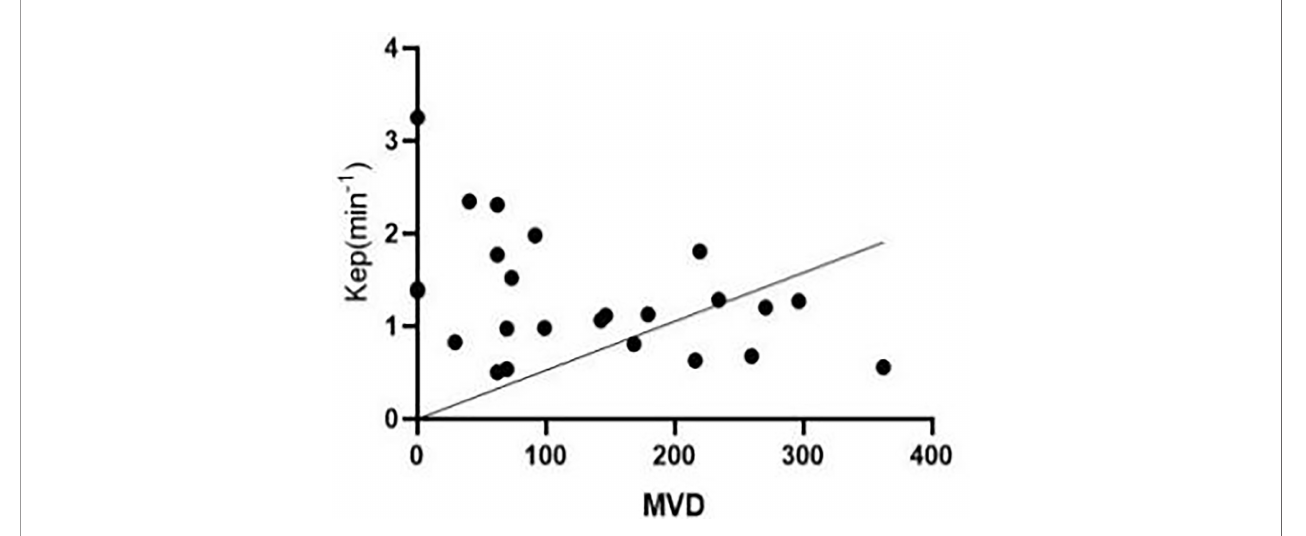
FIGURE 6 | At the third week after successful modelling, microvascular density (MVD) in the peripheral blood of experimental rabbits correlated negatively with Kep.